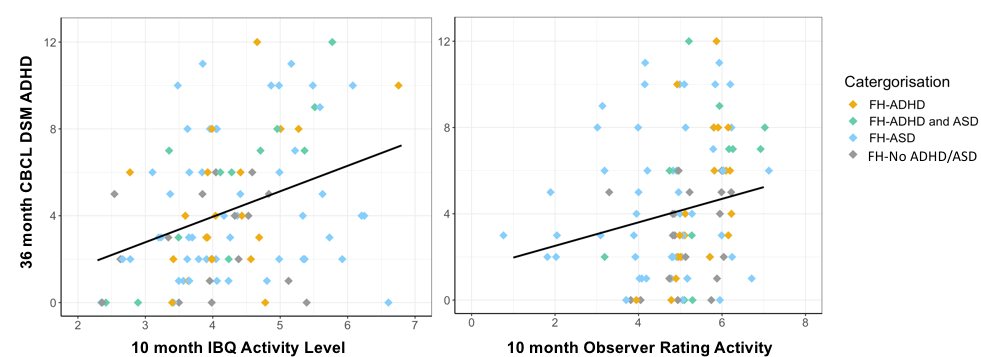
Figure 3. Infant activity level and 3-year preschool ADHD traits. Scatterplot for the full cohort with regression line showing 10-month activity level (left: IBQ-R Activity Level subscale, and right: observer ratings of activity level) on the x-axis, and the DSM-oriented ADHD subscale of the Child Behaviour Checklist (CBCL) at age 3 years on the y-axis, colour coded by family history group, with jitter due to discrete scales.